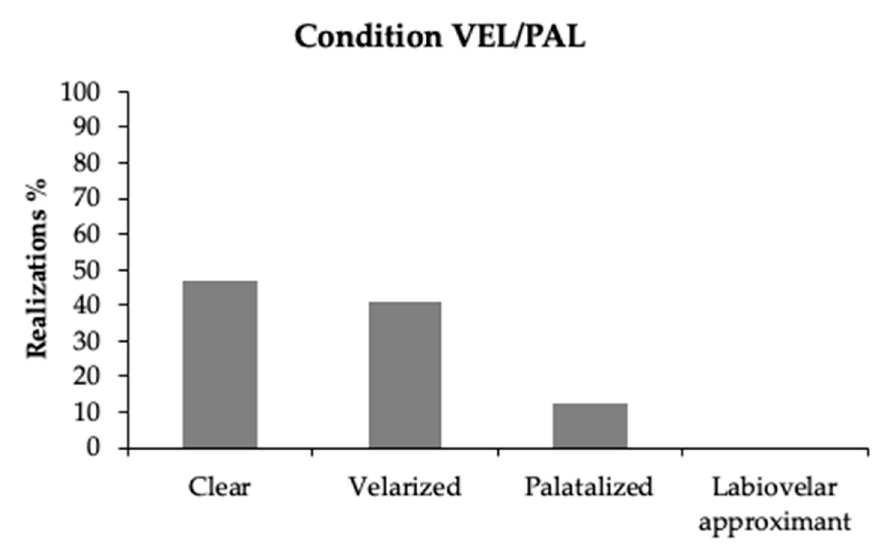
Figure 4. The production of the L3 lateral in condition VEL/PAL.